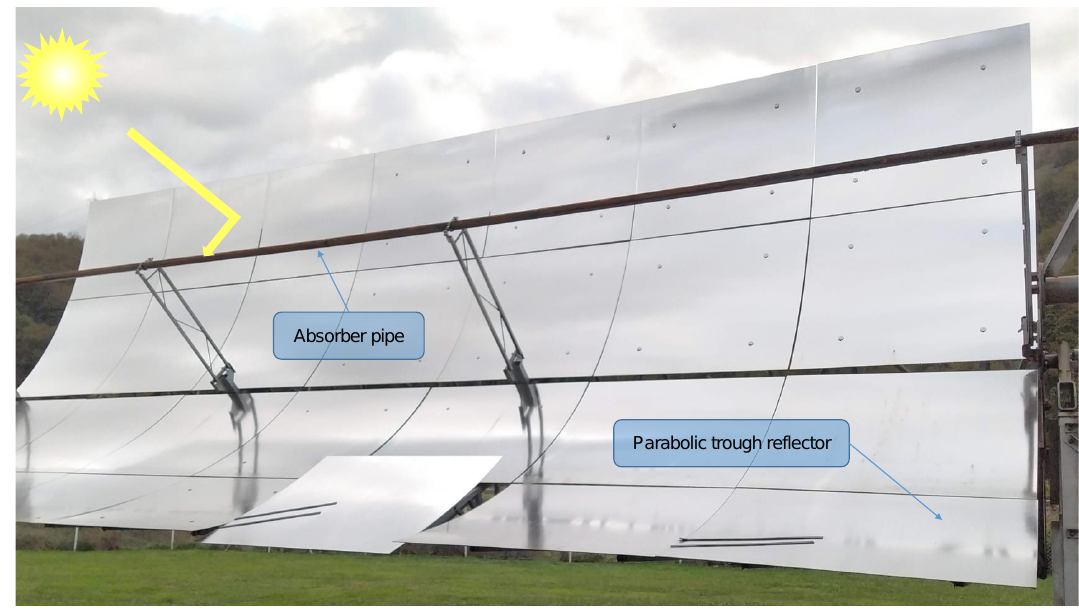
Figure 1. Parabolic trough